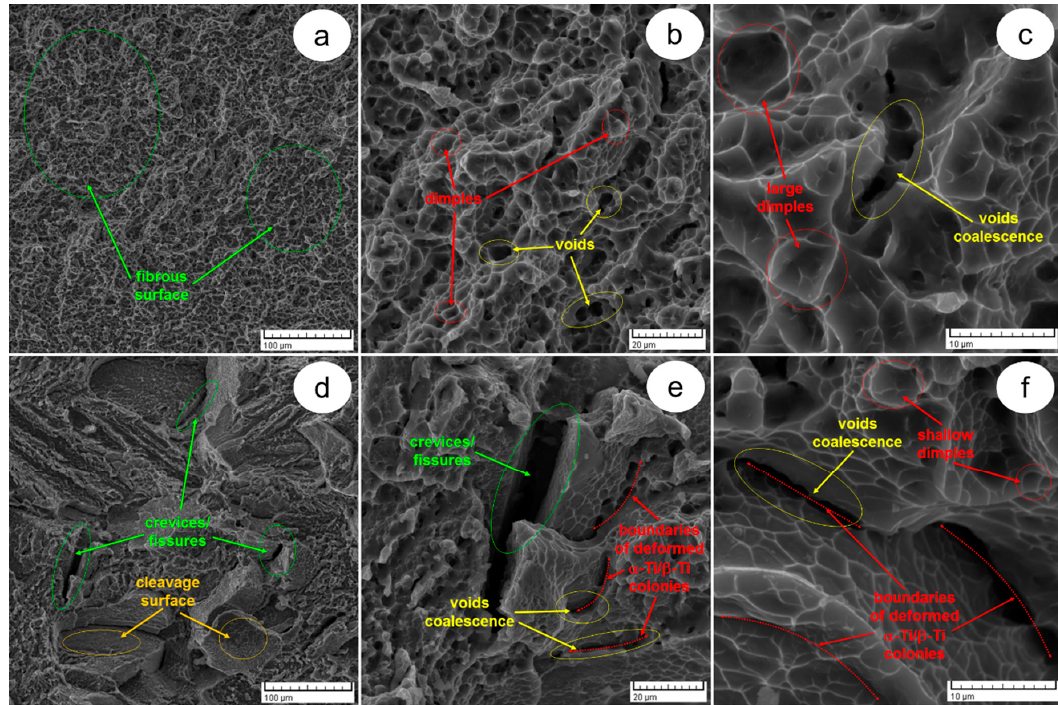
Figure 8. SEM-SE images of fracture surfaces after tensile testing of Ti-6246 alloy ( a–c ) in AR state in different magnifications; ( d–f ) HR state.